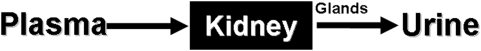
Kidney function analysis by black box method.